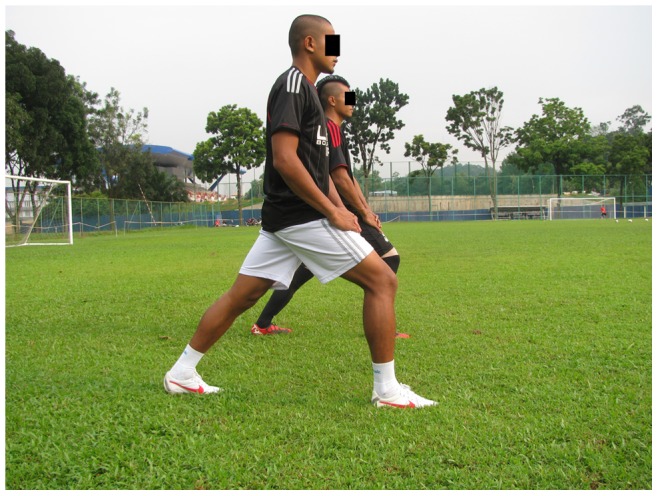
Activation of calf muscles.